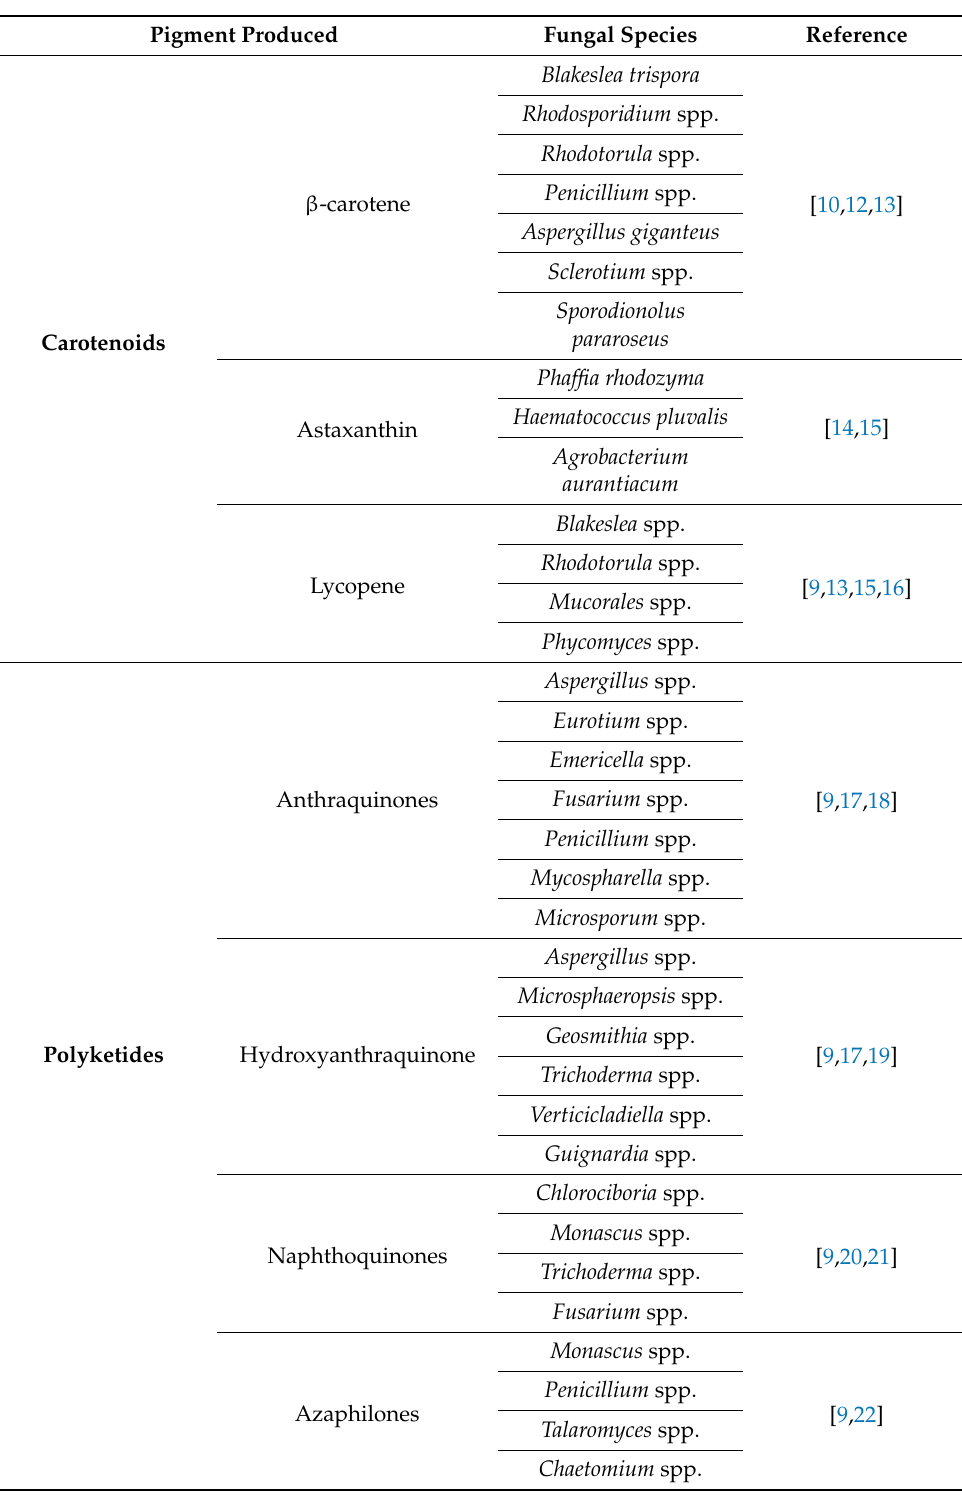
Table 1. More commonly produced pigments and their fungal